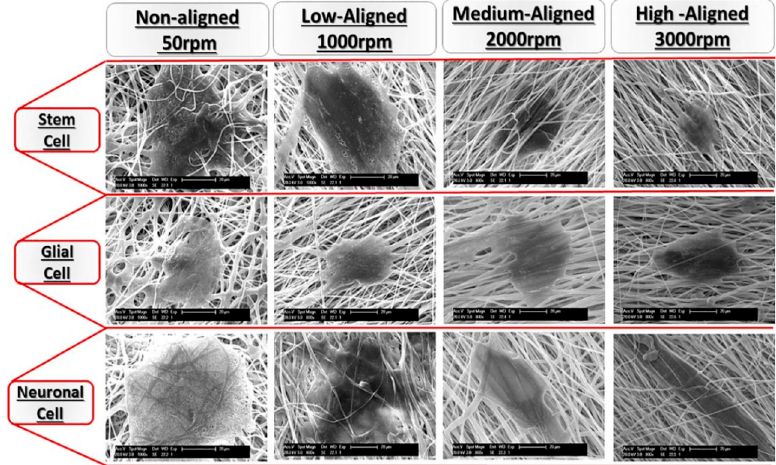
Figure 30. Scanning electron micrographs showing the morphologies of stem cell, neuronal cell, and glial cell cultivated on electrospun PVDF scaffolds with different fiber orientations. Reproduced with permission from [15], published by Wiley, 2017.